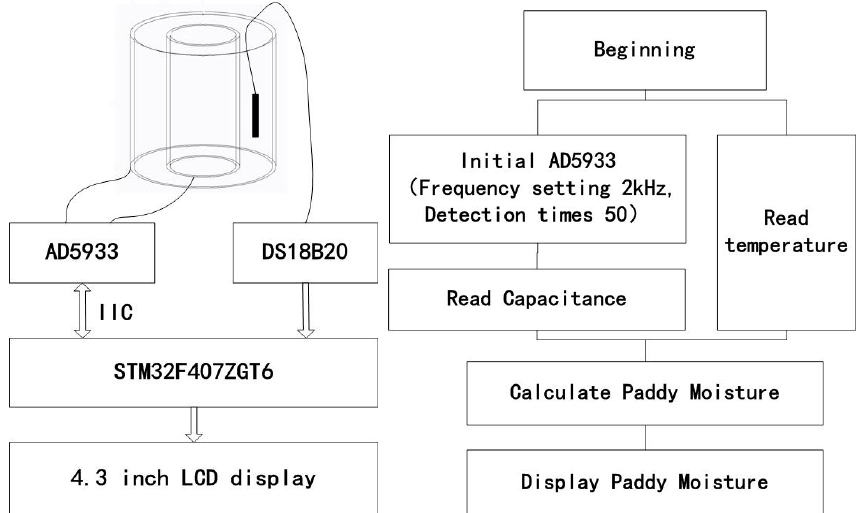
Figure 7. Hardware and software of the paddy moisture sensor.